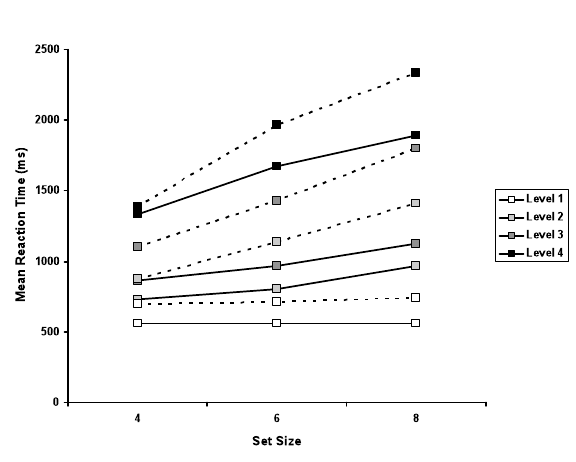
Figure 6. Mean (n = 5) reaction time course in the four levels of similarity and for target-present trials and target-absent trials (dotted lines) with increasing item number.